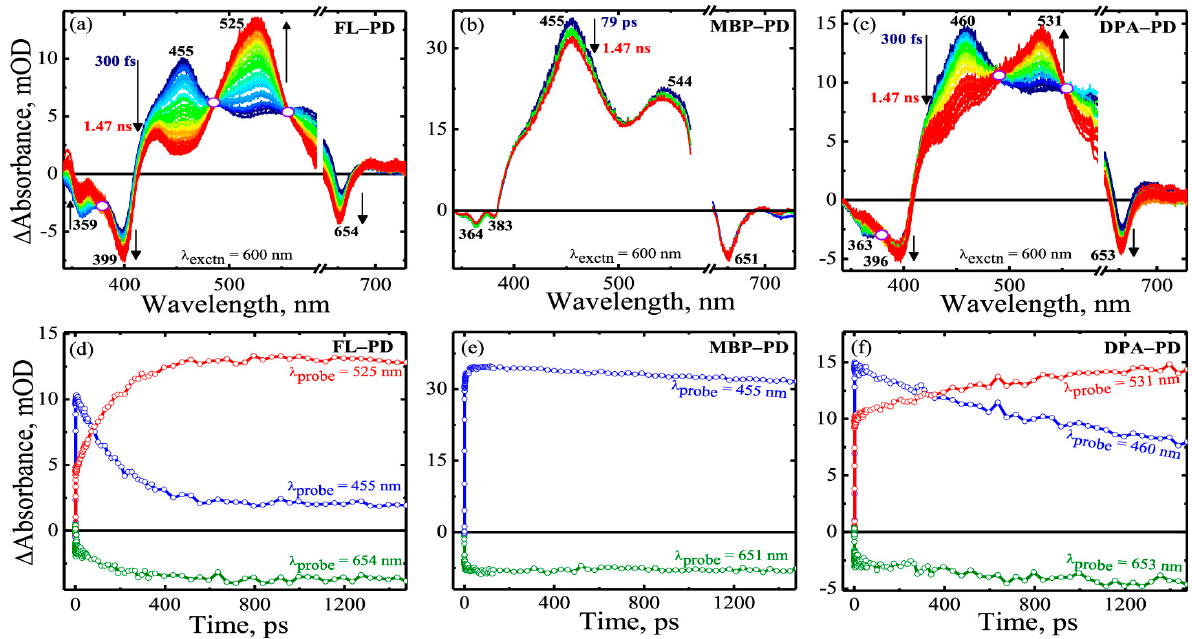
Figure 7. Femtosecond transient absorption spectra of ( a ) FL-PD, ( b ) MBP − PD, and ( c ) DPA − PD in toluene obtained upon excitation at 600 nm. The delay times are given and the arrows show the spectral evolution. Kinetic profiles of ( d ) FL − PD, ( e ) MBP − PD, and ( f ) DPA − PD probed at the maximum of singlet, triplet state absorption, and ground-state bleach are given. Reprinted with permission from Ref. [83]. Copyright 2021, American Chemical Society.